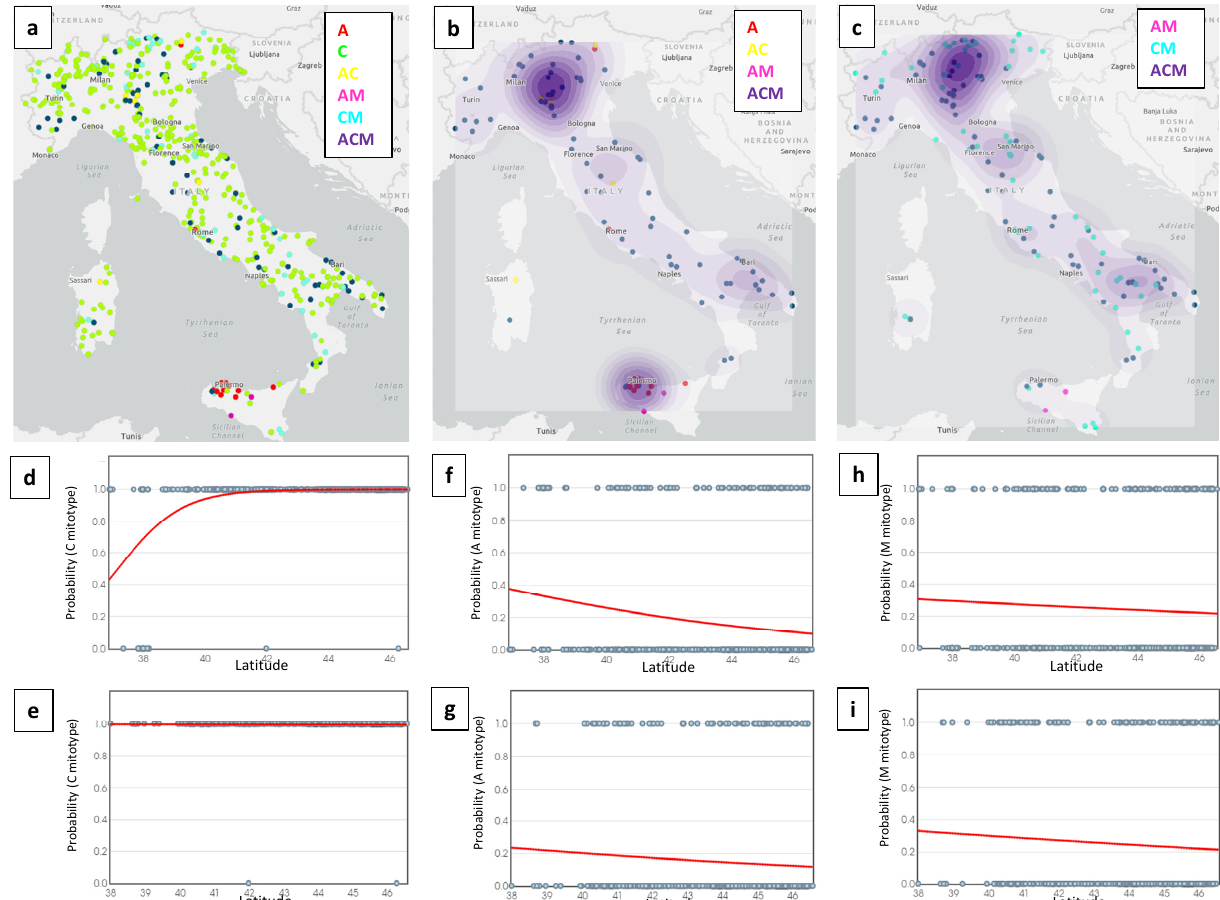
Figure 1. ( a ) Distribution of all analyzed honey samples in Italy with information on the mitotype patterns indicated with dots in the map with the same colors of the legend. ( b ) Density map of the analyzed samples carrying the A lineage. ( c ) Density map of the analyzed samples carrying the M lineage. ( d – i ) Logistic regression curves showing relationships between the occurrence of lineage C ( d , e ), including all Italian regions, i.e., the peninsula, Sardinia and Sicily ( d ); or only the peninsula data ( e ); lineage A ( f , g ), with all Italian regions ( f ); or only the peninsula data ( g ); lineage M ( h , i ), with all Italian regions ( h ); or only the peninsula data ( i ).